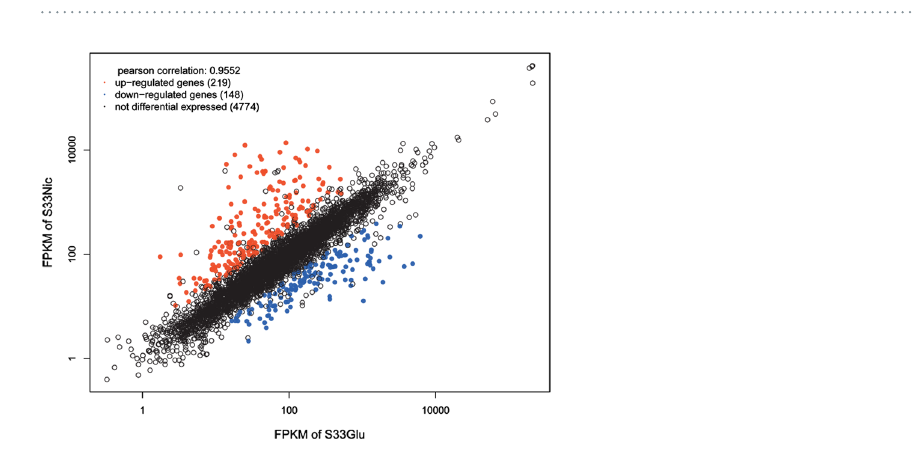
Figure 4. Density plot for genes expressed in A . tumefaciens S33 under two different nutrition conditions. S33Glu, cells grown in glucose-ammonium medium; S33Nic, cells grown in nicotine medium.